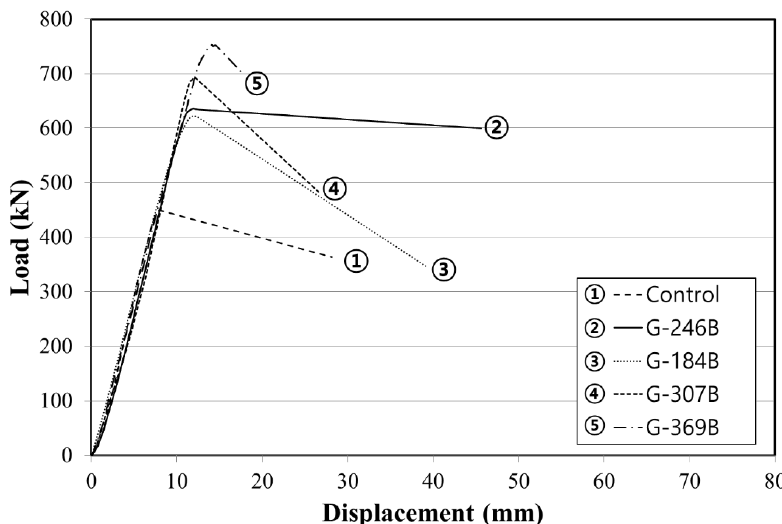
Figure 8. Load displacement curve (shear reinforcement).